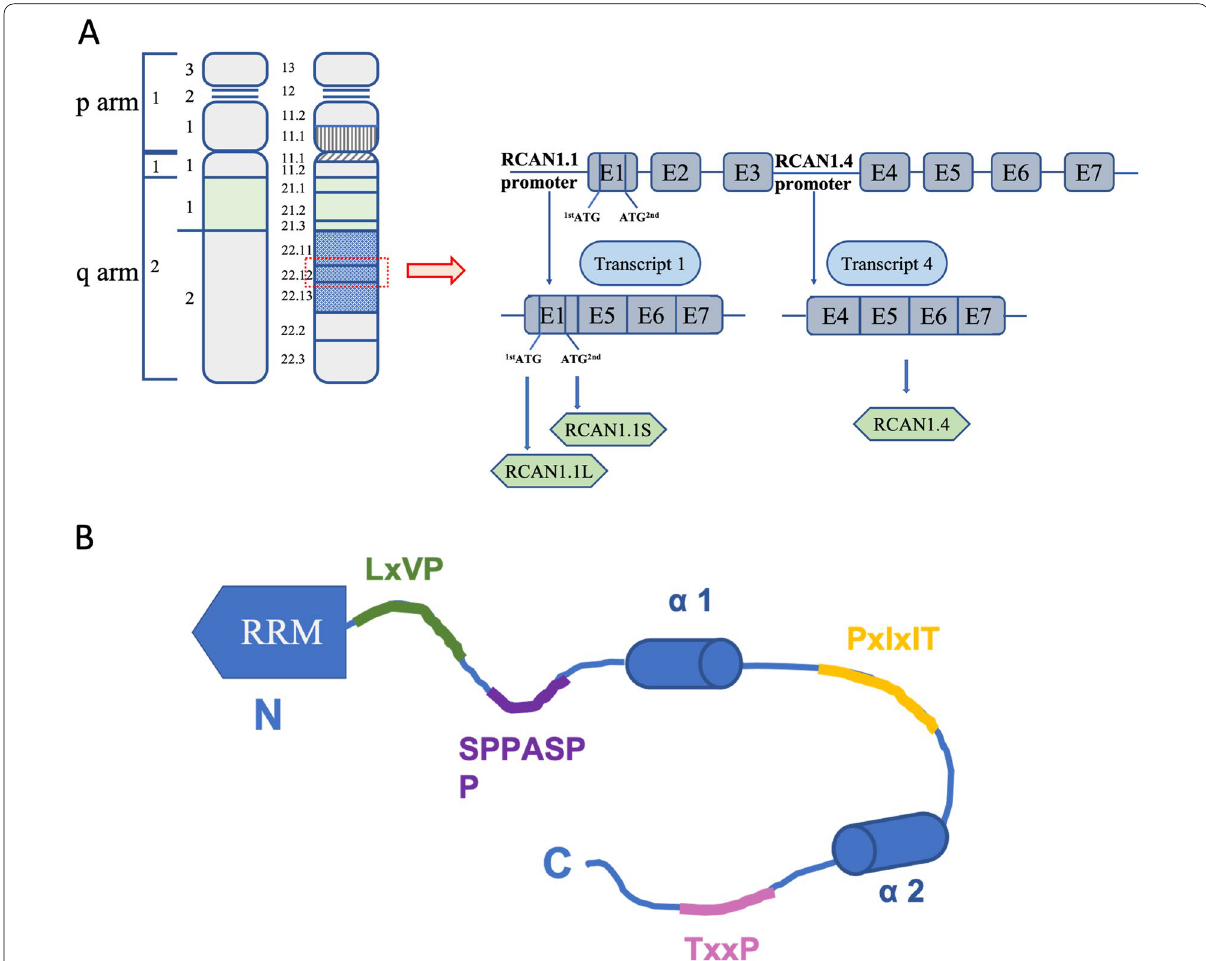
Fig. 1 RCAN1 gene and protein structure. A A schematic representation of the location of RCAN1 on human chromosome 21. RCAN1 is at location 21q22.12. Gene consists of seven exons (exon 1 to exon 7). By alternative mRNA splicing, two major transcripts, RCAN1.1 (E1, E5–E7) and RCAN1.4 (E4, E5–E7) are generated. By alternative usage of two in-frame translational start codons (presented as 1st ATG and 2nd ATG), two versions